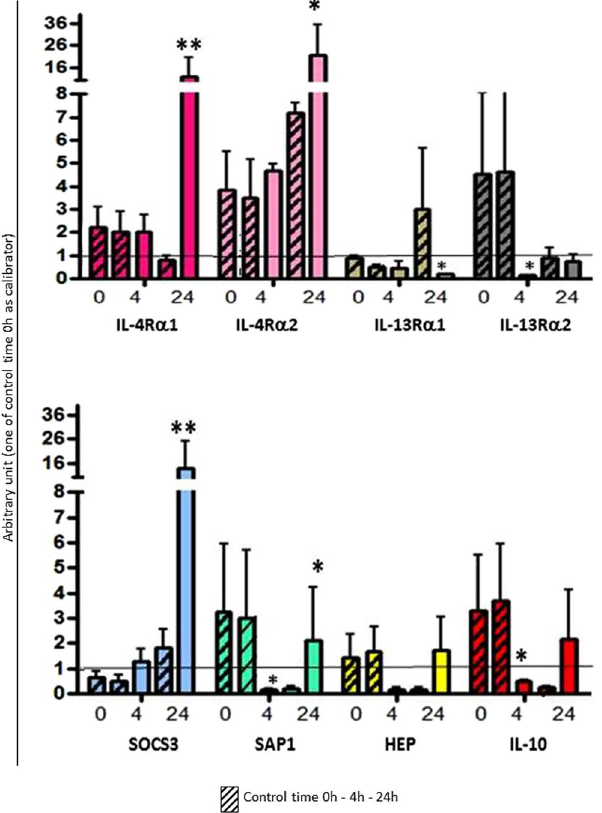
Figure 6. Biological activity of sea bass recombinant IL-4/13A1. The expression level of genes coding for IL- 4R α 1, IL-4R α 2, IL-13R α 1, IL-13R α 2, SOCS3, SAP1, HEP and IL-10 was determined in HK leukocytes after stimulation with the sea bass recombinant IL-4/13A1. Transcription values were expressed as a ratio relative to 18S rRNA in the same samples. The quantitative PCR amplification was performed in PCR arrays and each point represents the mean + SD of cells from 4 individual fish. * p < 0.05 with respect to the time 0 control; ** p < 0.01 with respect to the time 0